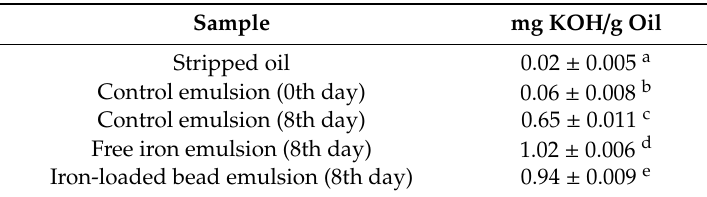
Table 2. Free fatty acid values in stripped rapeseed oil, and in emulsions. Values are the average ± standard deviation of three measurements performed on two independently prepared batches. Values marked with di ff erent letters are significantly di ff erent according to Tukey’s b test ( p < 0.05).